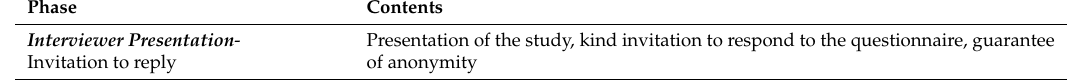
Table 2. Description of the main contents of the